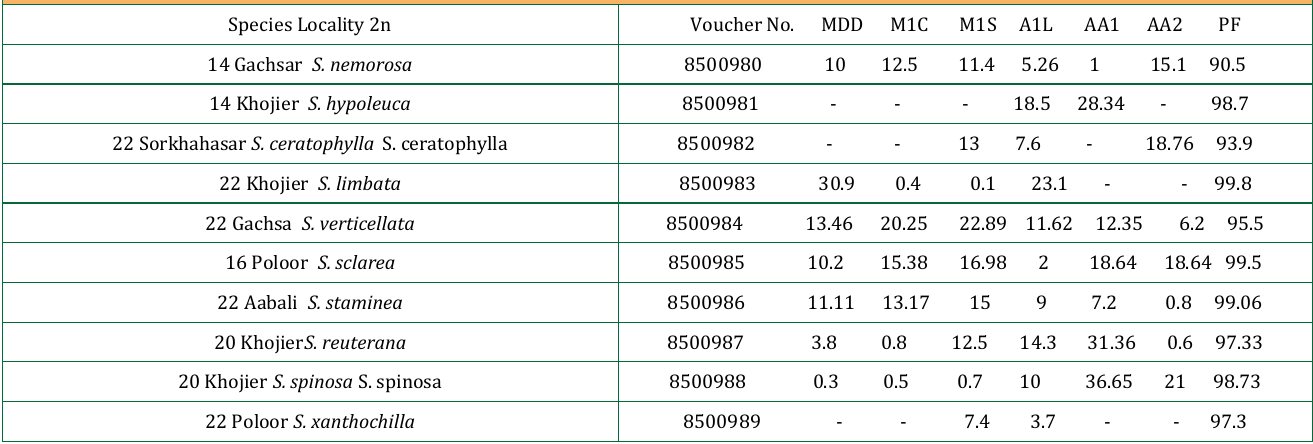
Table 1: Meiotic abnormalities in salvia species studied. (All values are in percentage) Species Locality